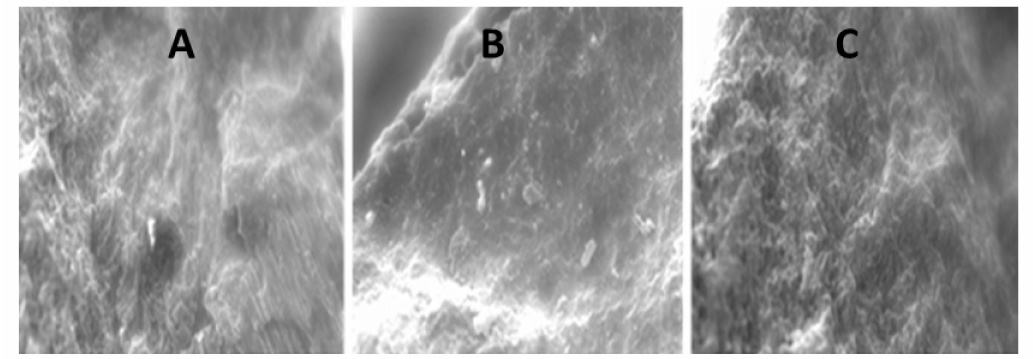
Figure 9. SEM images of ( A ) C - FeCl